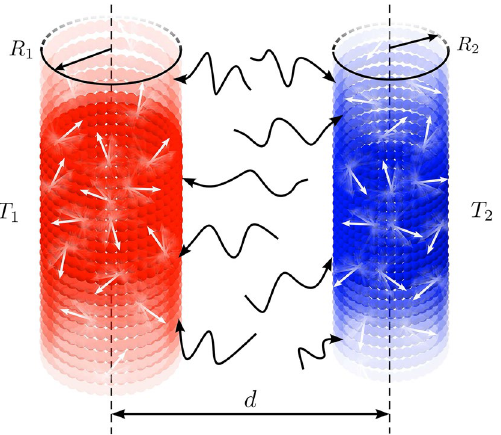
Figure 1. Radiative heat exchange between two parallel infinite-length carbon nanotubes of radii R 1 and R 2 , separated by a distance of d . The nanotubes are at different temperatures, T 1 and T 2 . The z -coordinate is directed along the nanotube axis while the x - and y -coordinates lie in the azimuthal